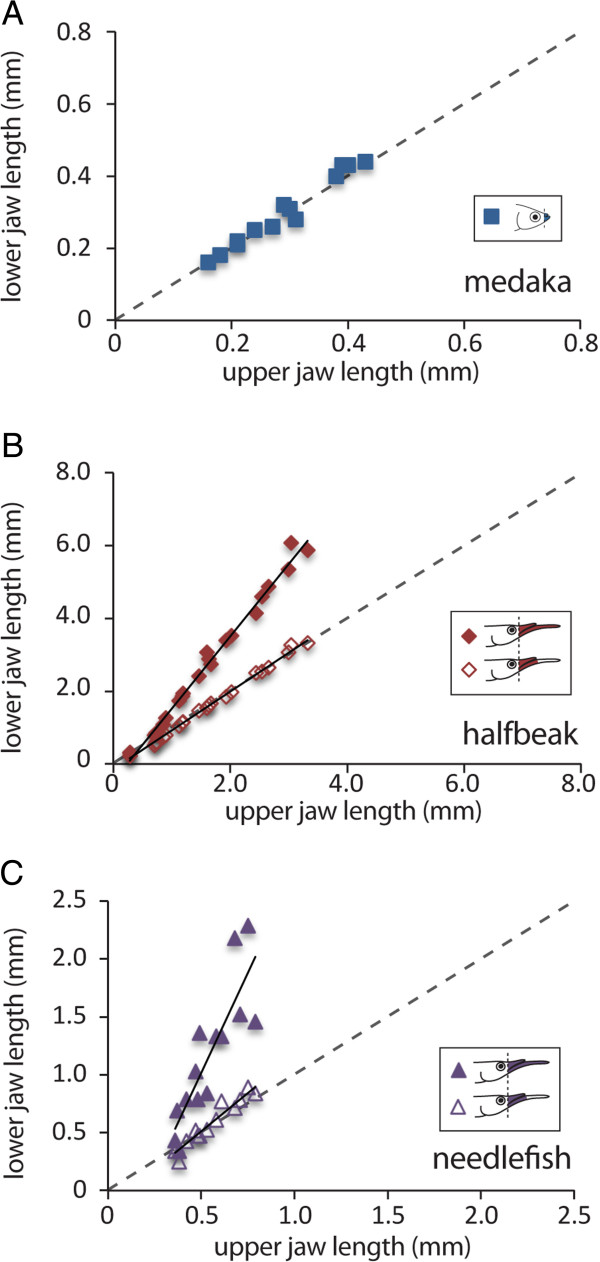
The toothless extensions form the basis for heterochronic shifts in jaw growth amongst the Belonoidei. Allometric plots displaying ratios between upper and lower jaw growth for (A) medaka, (B) halfbeak, and (C) needlefish as well as ratios between upper and lower jaw excluding the toothless extensions for (B) halfbeak and (C) needlefish. (A) The jaws of medaka, which display the ancestral condition, undergo isometric growth (represented by the dashed line). (B) Comparison between upper and lower jaw growth for halfbeak indicates growth acceleration in favour of the lower jaw, while comparison between upper and lower jaw excluding the toothless extensions indicates isometric growth (represented by the dashed line). (C) A similar pattern to halfbeak is observed in needlefish. Note, needlefish growth trajectory is based on only the data points prior to growth acceleration of the upper jaw.